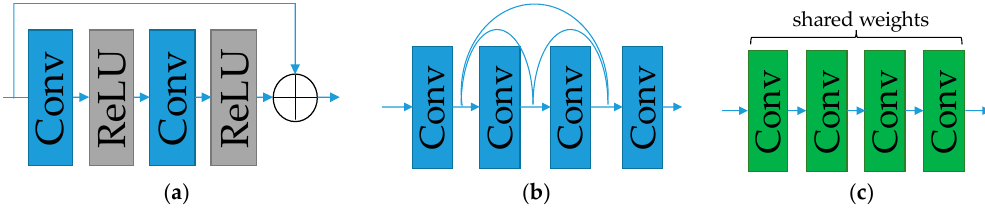
Figure 2. ( a ) skip connection: Both the global residual connection that links the input data and the output layer and the local residual connection from ResNet [24] alleviate the learning difficulty. ( b ) dense connection structures link all layers in the network and concatenate all of the preceding layers’ feature maps to alleviate vanishing gradients and reuse the features from shallow layers. ( c ) The green box refers to the recursive convolutional layer. Recursive neural networks repeatedly apply the same convolutional layers to control the parameters while achieving a large receptive field. Since there is a high correlation between the input image and the target HR image, many methods such as VDSR [2], EDSR [16], WDSR [17], SRResNet [25], SRDCN [26], and DRRN [27] use the local residual path from ResNet [24] and the global residual path to propagate the information from the shallow layer to the final reconstruction layer . Several methods based on DenseNet [27] like SRDenseNet [28] and RDN [29] use a concatenation strategy to combine preceding features to a bottleneck layer for reconstruction. MemNet [30], CARN [31], RDN [29], ESRGAN [32], and DBPN [33] also adopt dense connection to alleviate vanishing gradients and reuse the features from shallow layers. To control the parameters while achieving a large receptive field, DRCN [22] repeatedly applied the same convolutional layer at 16-recursions to reach a receptive field of 41 by 41. The DRRN [23] proposes a recursive block consisting of several residual units and shares the weights among these residual units to further improve its performance. In the SR task, recurrent neural networks are usually implied in video SR to capture the long- term dependency from neighboring frames [34]. BRCN [35,36] consists of three parts: The feedforward convolutional layer to capture the spatial dependence between LR and HR, the bidirectional recurrent convolutional network to capture the temporal dependency between successive frames, and the conditional convolutional layer to further capture spatial-temporal dependency. STCN [37] proposes a bidirectional LSTM structure to capture spatial-temporal information for video frame reconstruction. For single image SR, based upon the idea of viewing a ResNet as an unrolled RNN [38,39], DSRN [40] proposes a dual-state recurrent network, and each state operates at the LR and HR spatial resolution separately to explore the connection between the LR and HR pairs and provides information flow from LR to HR at every recursion. In the remote sensing area, Hua et al. [41] proposed a novel RNN model for hyperspectral image classification which can effectively analyze hyperspectral pixels as sequential data. Convolutional LSTM was utilized to address the spectral-spatial feature learning problem and extract more discriminative and abstract features for hyperspectral image classification [42–44]. Besides that, Mou et al. [45] proposed a recurrent convolutional network architecture to effectively analyze temporal dependence in bitemporal images for multitemporal remote sensing image analysis. In this paper, we proposed a BiConvLSTM SR network (BCLSR) for remote sensing images. Our intuition was that in order to reduce the model parameters while increasing the receptive fields of our network, we had to build a recursive inference block with dense connection to extract the hierarchical features. In the structure of the recursive inference block, paths are created between a layer and every preceding layer to strengthen the flow of information through deep networks and reuse the features extracted in the previous layers. Since there is redundancy and complementarity between each recursion, we inserted a BiConvLSTM layer to effectively learn the correlations of each different level and select the complementary information for the reconstruction layer. To fuse the hierarchical features extracted from the recursive inference block, we concatenated the recursions of the recursive inference block to a temporal sequence in the order of the recursion and passed through this sequence to the BiConvLSTM layer to extract complementary information from the low-level features. Due to the high correlations of the LR and HR images, we constructed a global residual path